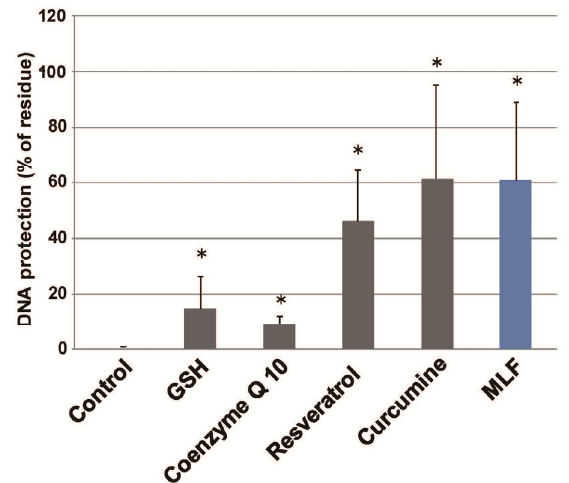
Figure 3. Protective effects of LFs and various antioxidants on calf thymus DNA strand breaks of p following exposure to •OH generated by the UV-H 5 μ M MLF and various other compounds (5 mM GSH, 50 μ M resveratorol, 50 μ M curcumine, and 50 μ M Coenzyme Q10) were determined by electrophoresis of DNA. Electrophoresis of calf thymus DNA using agarose gel (1.0%) was performed following exposure to UV irradiation (254 nm) with 5 mM H compounds. Reactions were conducted for 10 min at room temperature. DNA protection (%) was calculated based on the densitometry of EtBr-stained bands vs. control band intensities. Data are presented as the mean ± S.D. of triplicate determinations. * p < 0.05 compared to the control value was considered as a statistically significant